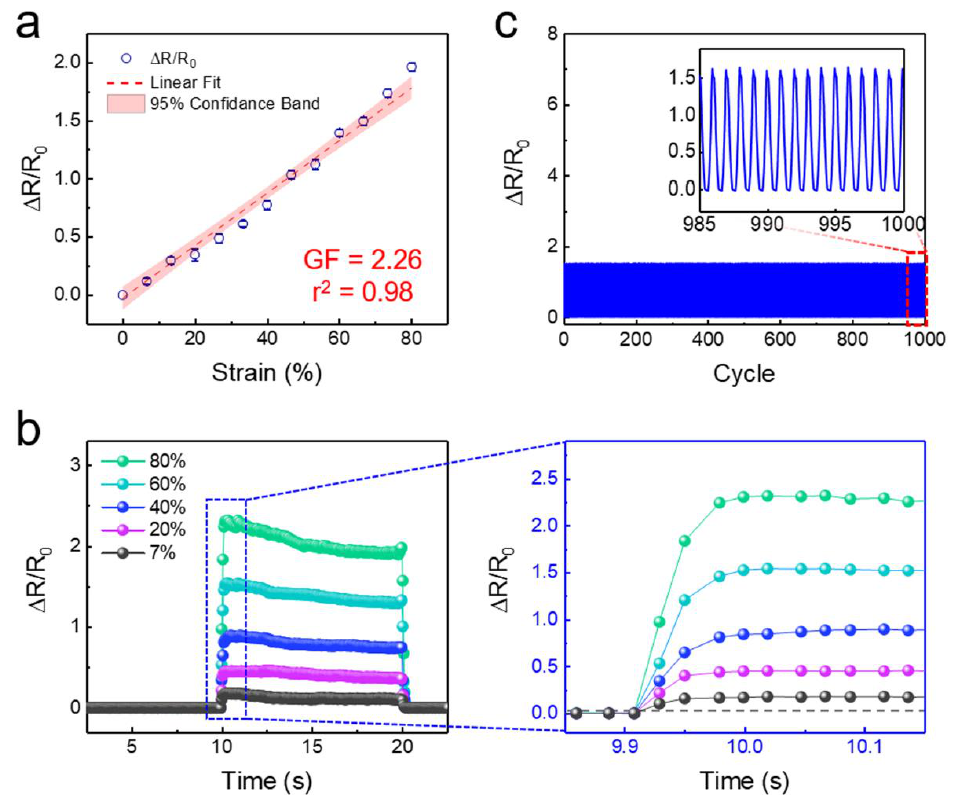
Figure 3. Strain sensing behavior of the self-attachable strain sensor. ( a ) Relative resistance change as a function of applied strain. The average values and error bars are based on five measurements. Error bars represent the standard deviation ( < 0.05). The standard error of the gauge factor (GF) is 0.024. ( b ) Time-resolved measurement of the relative resistance at di ff erent applied strains. ( c ) Durability of the sensor after repeated cycles of an applied strain (60%) (frequency: 0.067 Hz, duration of each cycle: 15 s).